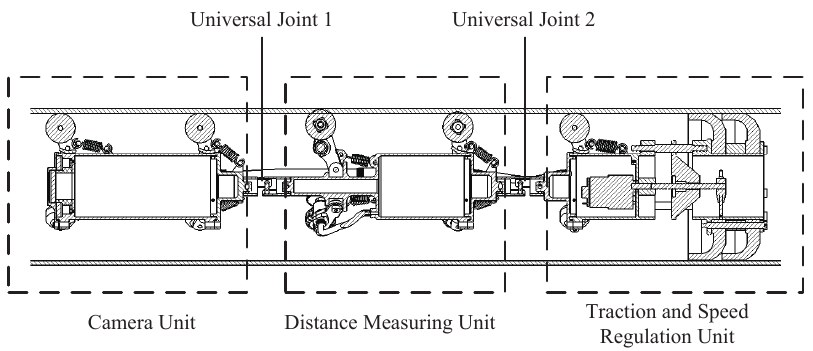
Figure 1. Structura drawing of GDPER.